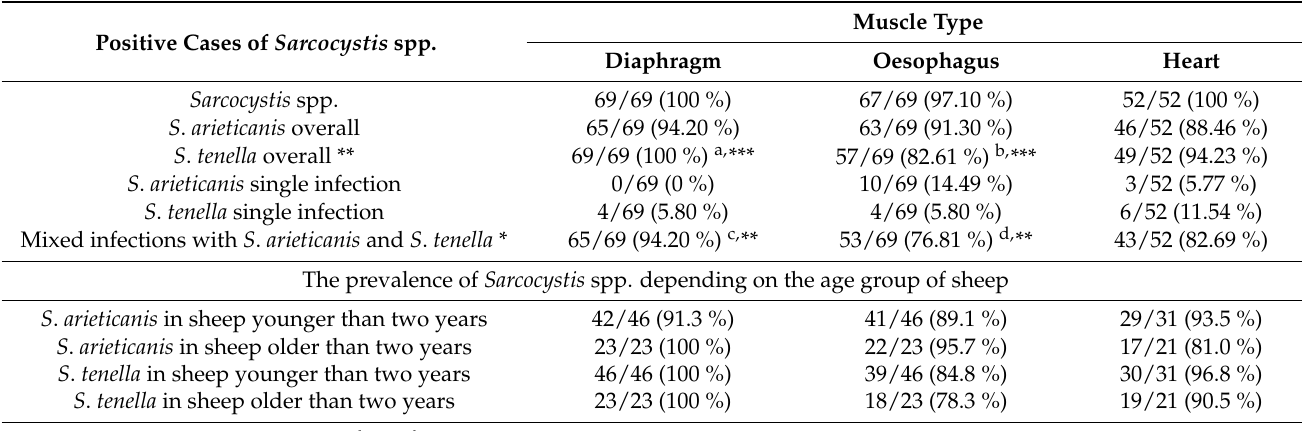
Table 4. The distribution of S . arieticanis and S . tenella in different muscle types of sheep raised in